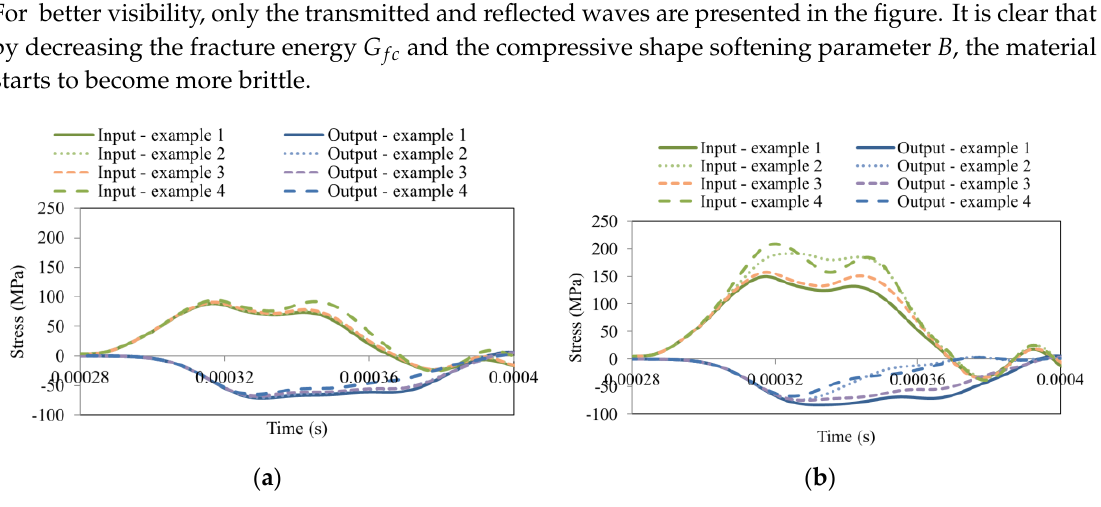
Figure 12. The waves in simulation of dynamic compression using SHPB for parameters from the current work; ( a ) 10 m/s, ( b ) 30 m/s .